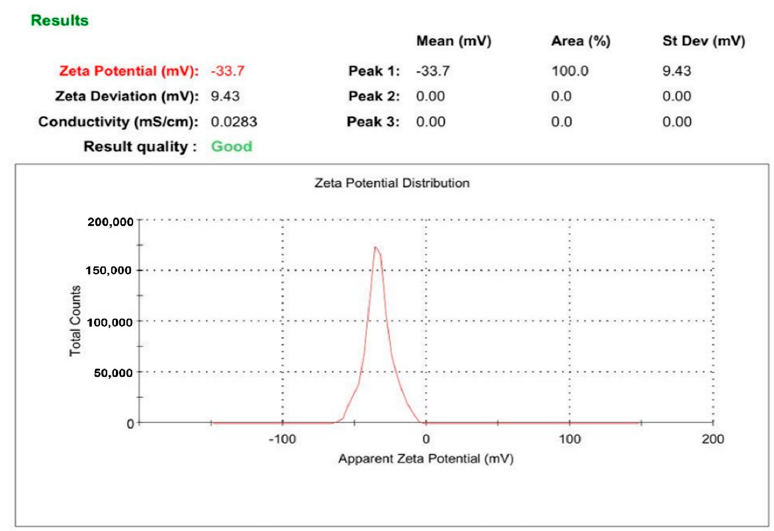
Figure 3. Zeta potential of L-AgNPs.